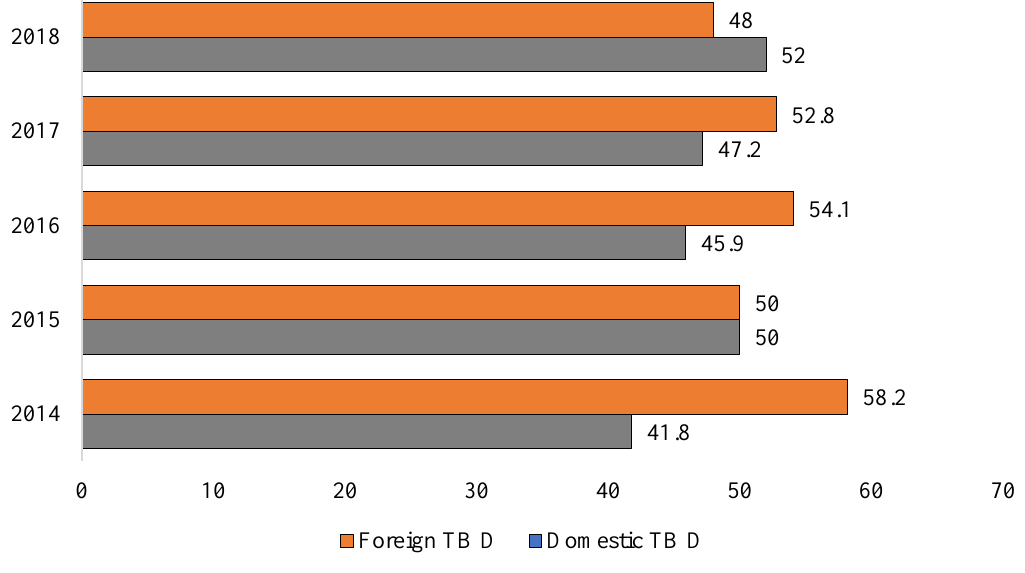
Fig. 5. The analysis of government spending on purchases of anti-TB D in the context of domestic and foreign production, %